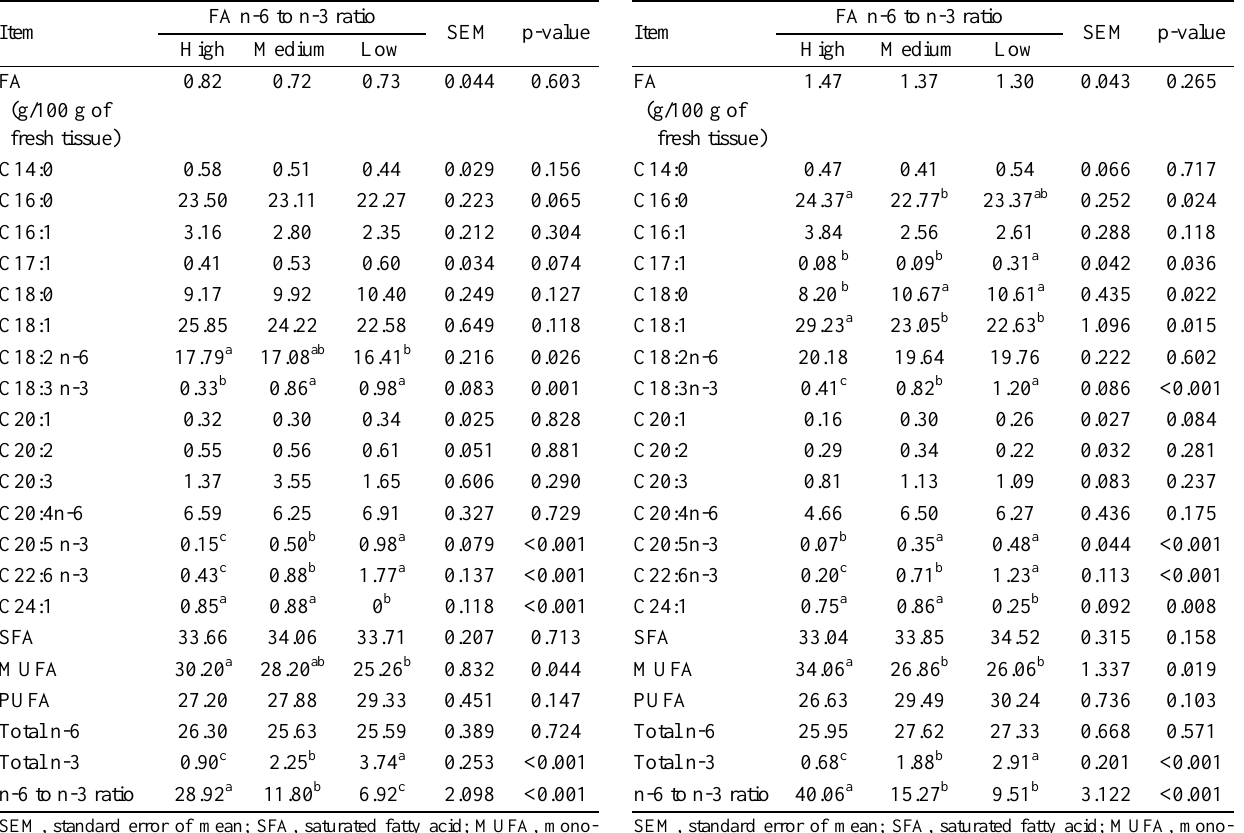
Table 4. Fatty acid (FA) concentrations (g/100 g of total FA) in breast muscles of broiler chicken fed diets with different n-6 to n- 3 FA ratios